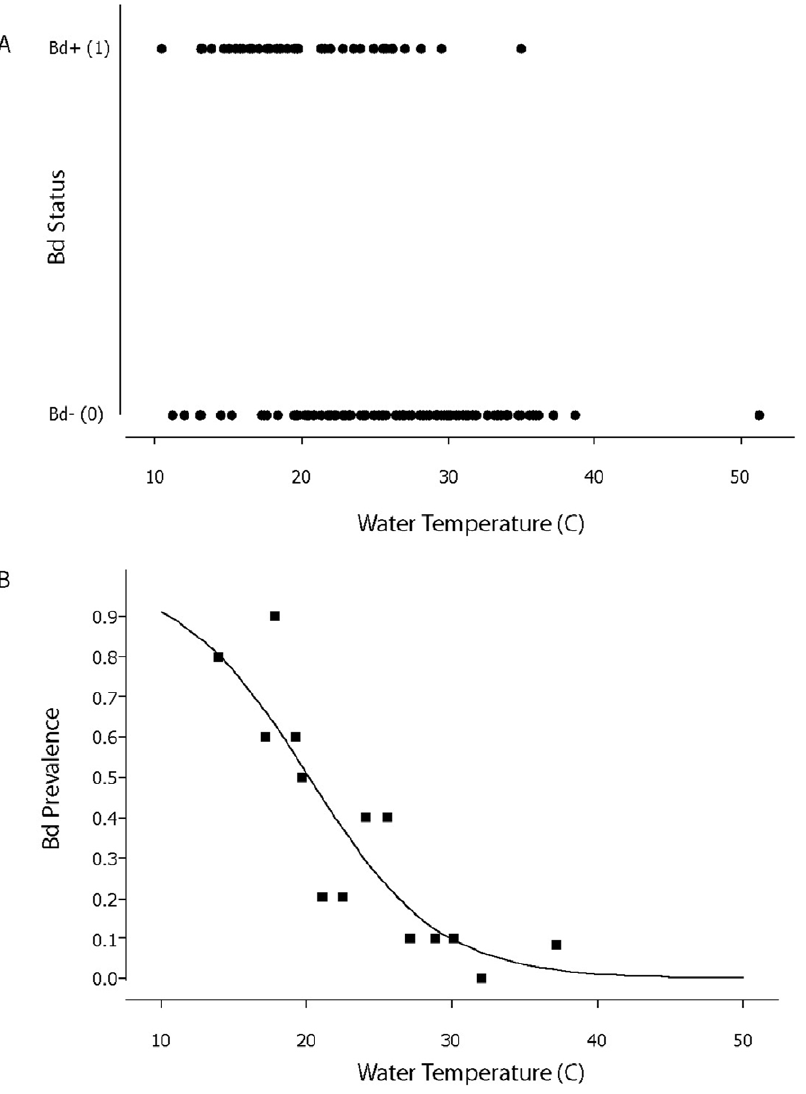
Figure 1. Occurrence of Bd in lowland leopard frogs as a function of water temperature. A) Presence (1) and absence (0) of Batrachochytrium dendrobatidis ( Bd ) in lowland leopard frogs Rana ( Lithobates ) yavapaiensis as a function of water temperature across all years and sites. N=50 Bd + individuals and N=151 Bd 2 . B) Occurrence of Bd in lowland leopard frogs as a function of water temperature, excluding four sites where Bd was not detected (see Table 1 for details). Each point represents the fraction of frogs infected and mean water temperature of groups of 10–12 individuals (ranked by water temperature, then binned). Logistic equation: y=1/(1 + e 2 z ) where z=4.56 - temp*0.226 (coefficients extracted from univariate analysis). Total sample size from sites with Bd ,